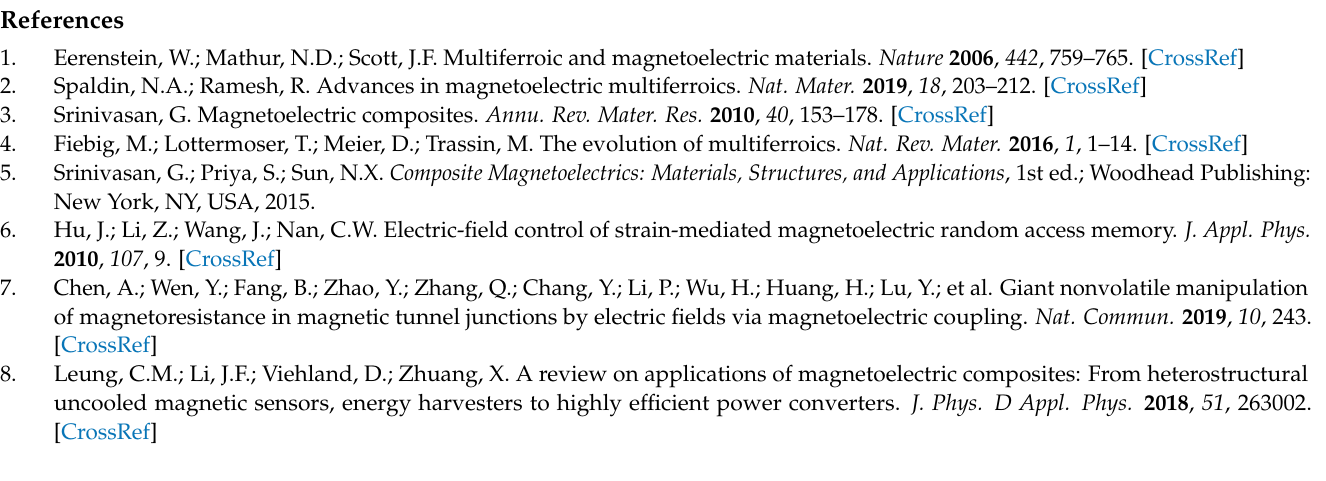
(BTO); Figure S2: SEM images for core-shell nanofibers; Figure S3: SMM images for core-shell fibers; Figure S4: SMM capacitance images for core-shell fibers; Figure S5: M vs H data for core-shell fibers; Figure S6: M vs H data for core-shell fibers; Figure S7: M vs H data for core-shell fibers; Figure S8: P vs E data for core-shell fibers; Figure S9: P vs E data for core-shell fibers; Figure S10: P vs E data for core-shell fibers; Figure S11: FMR profiles for core-shell